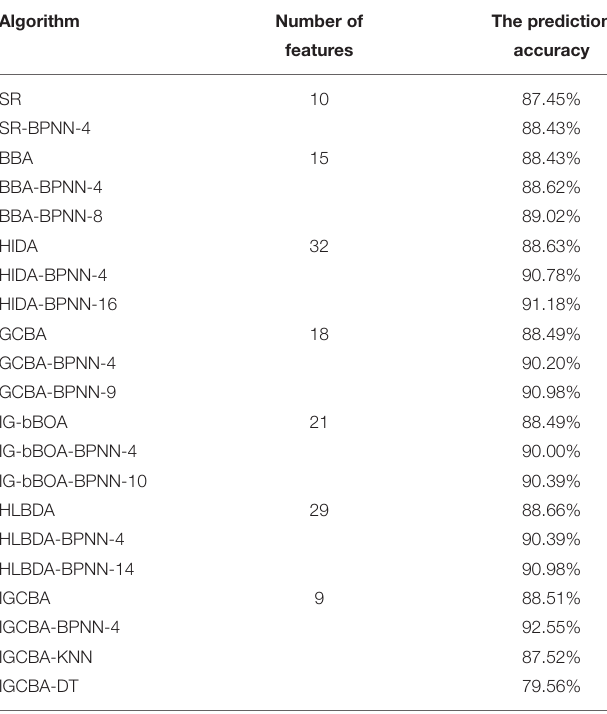
TABLE 5 | Comparison of prediction accuracy of different algorithms. Algorithm Number of The